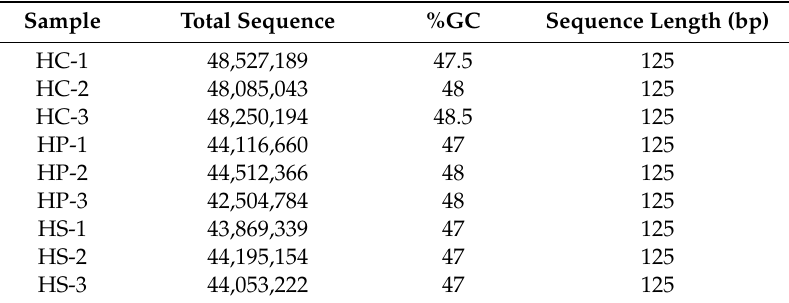
Table 1. Summary of RNA-Seq data.